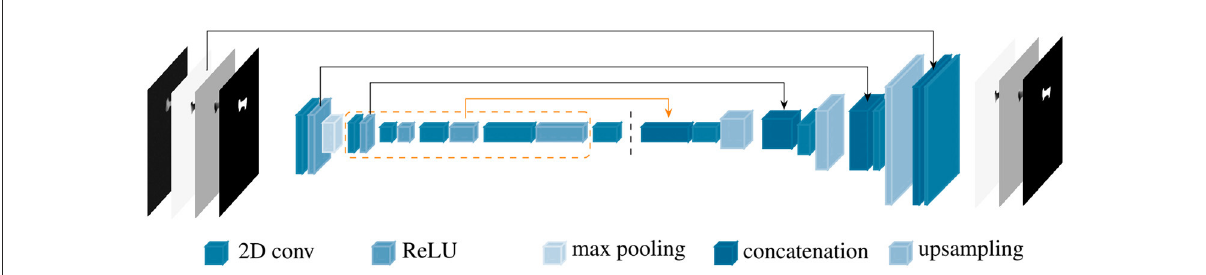
FIGURE3 BoneNet, the proposed customized network architecture for automatic 2D landmarks detection of a complex biological object with newly added basic blocks in the convolution blocks (orange dashed lines) and connection (orange arrow). The vertical, dashed line separates the feature learning (left) and the interpolation stage (right) of the deep